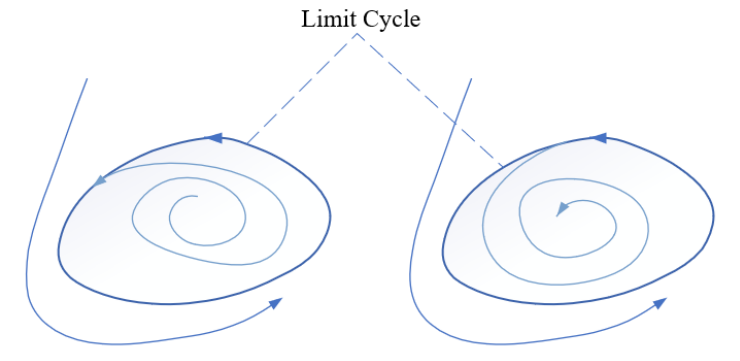
Figure 2. Schematic of stable ( left ) and unstable ( right ) limit